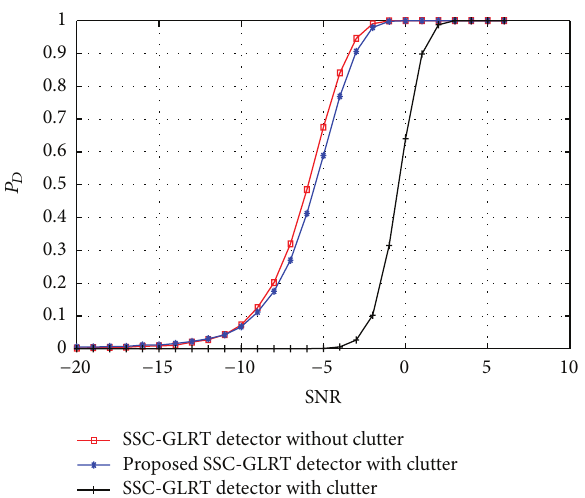
Figure 4: 𝑃 𝐷 comparison of a conventional SSC-GLRT detector and the proposed SSC-GLRT detector in the presence of clutter at 80% compression.